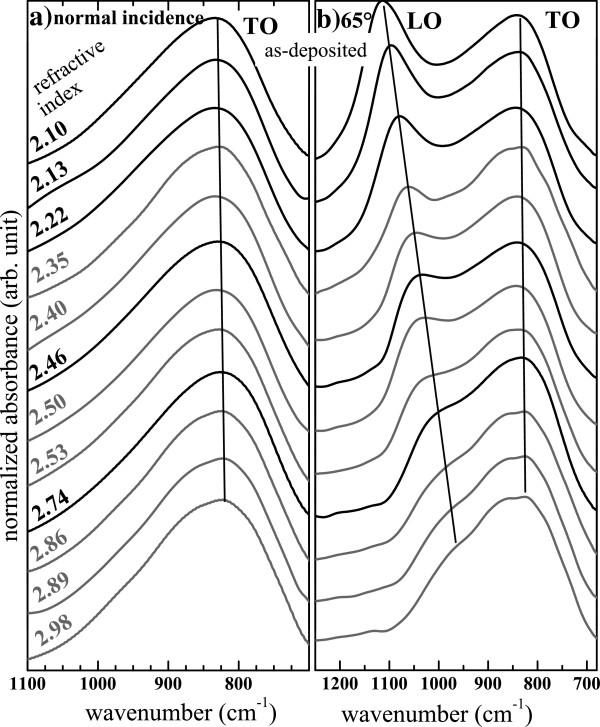
Evolution of the FTIR spectra of SiNxwith the refractive index. The FTIR spectra of the layers deposited by the N2-reactive (black) and the co-sputtering (gray) methods were measured with a normal incidence (a) and with an incidence angle of 65° (b).